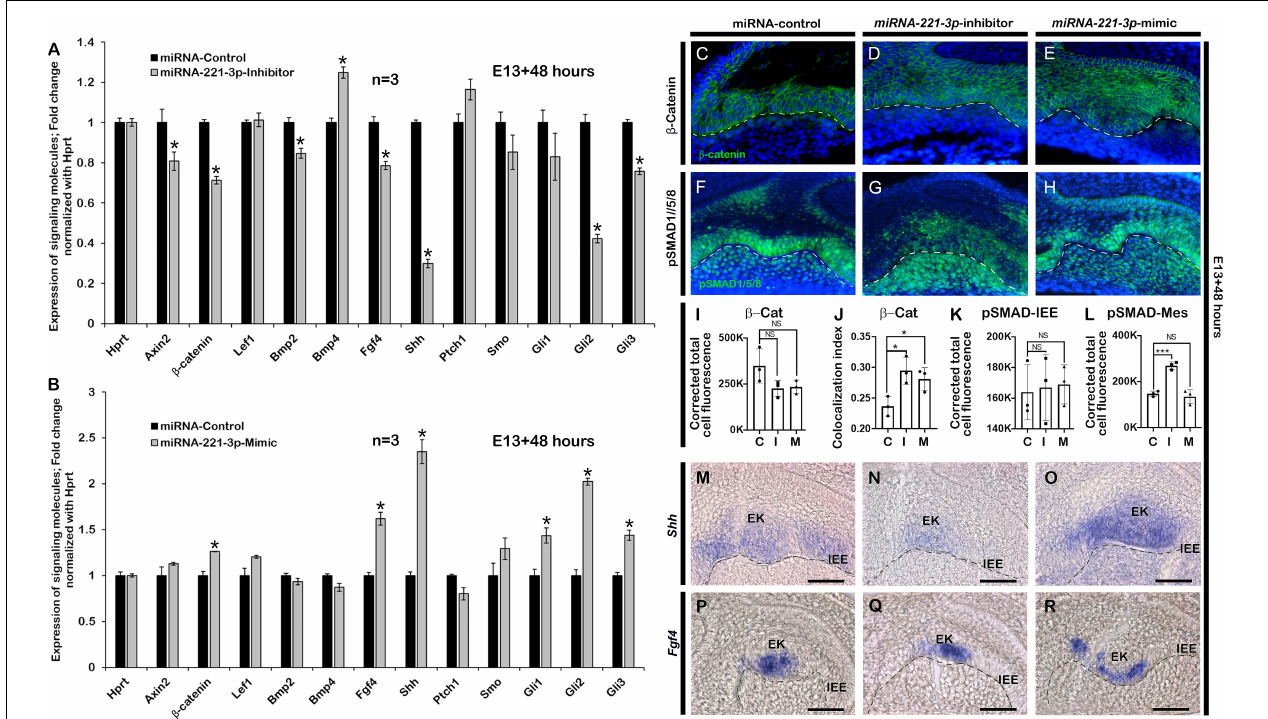
FIGURE 3 | Altered expressions of signaling molecules after loss and gain of function of miRNA-221-3p . Signaling molecules including Axin2 , β -catenin , Bmp2 , Bmp4 , Fgf4 , Shh, Gli1, Gli2 , and Gli3 are significantly altered in the inhibitor and mimic-treated specimens ( A,B , n = 3) (corresponding to data in Supplementary Table 2B ). Epithelial localization of β -catenin (green) along IEE, showing comparatively increased nuclear localization of β -catenin in the inhibitor and mimic-treated specimens compared to control ( C–E , I,J , n = 3). DAPI (blue) stains the nuclei. Epithelial and mesenchymal localization pattern of pSMAD1/5/8 (green) after inhibition and mimic of miRNA-221-3p , showing intense mesenchymal localization in the inhibitor-treated specimens compared to control and mimic ( F–H,K,L , n = 3). Section in situ hybridization of in vitro cultivated tooth germs showing expressions of Shh ( M–O , n = 3) and Fgf4 ( P–R , n = 3) along the EK and IEE. β -Cat, β -Catenin;